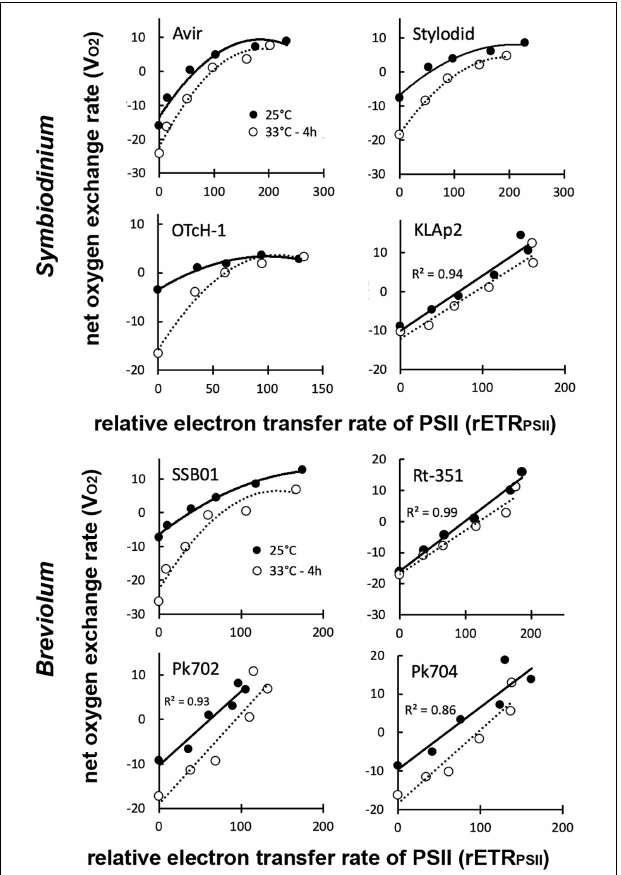
FIGURE 3 | Comparison of net oxygen evolution (V O2 ) and electron transport rate of photosystem II (rETR PSII ) in Symbiodinium and Breviolum strains. Samples were analyzed at time 0 (25 ◦ C) and after 4 h at 33 ◦ C. All measurements were performed on three biological replicates and data are presented as means. For details about rETR PSII ( µ mol electrons m − 2 s − 1 ) and V O2 (pmol O 2 µ g chl − 1 s − 1 ) measurements, including standard deviations, see Supplementary Figures 2, 3 , respectively. Correlation coefficient of linear regression are given only for dataset at 25 ◦